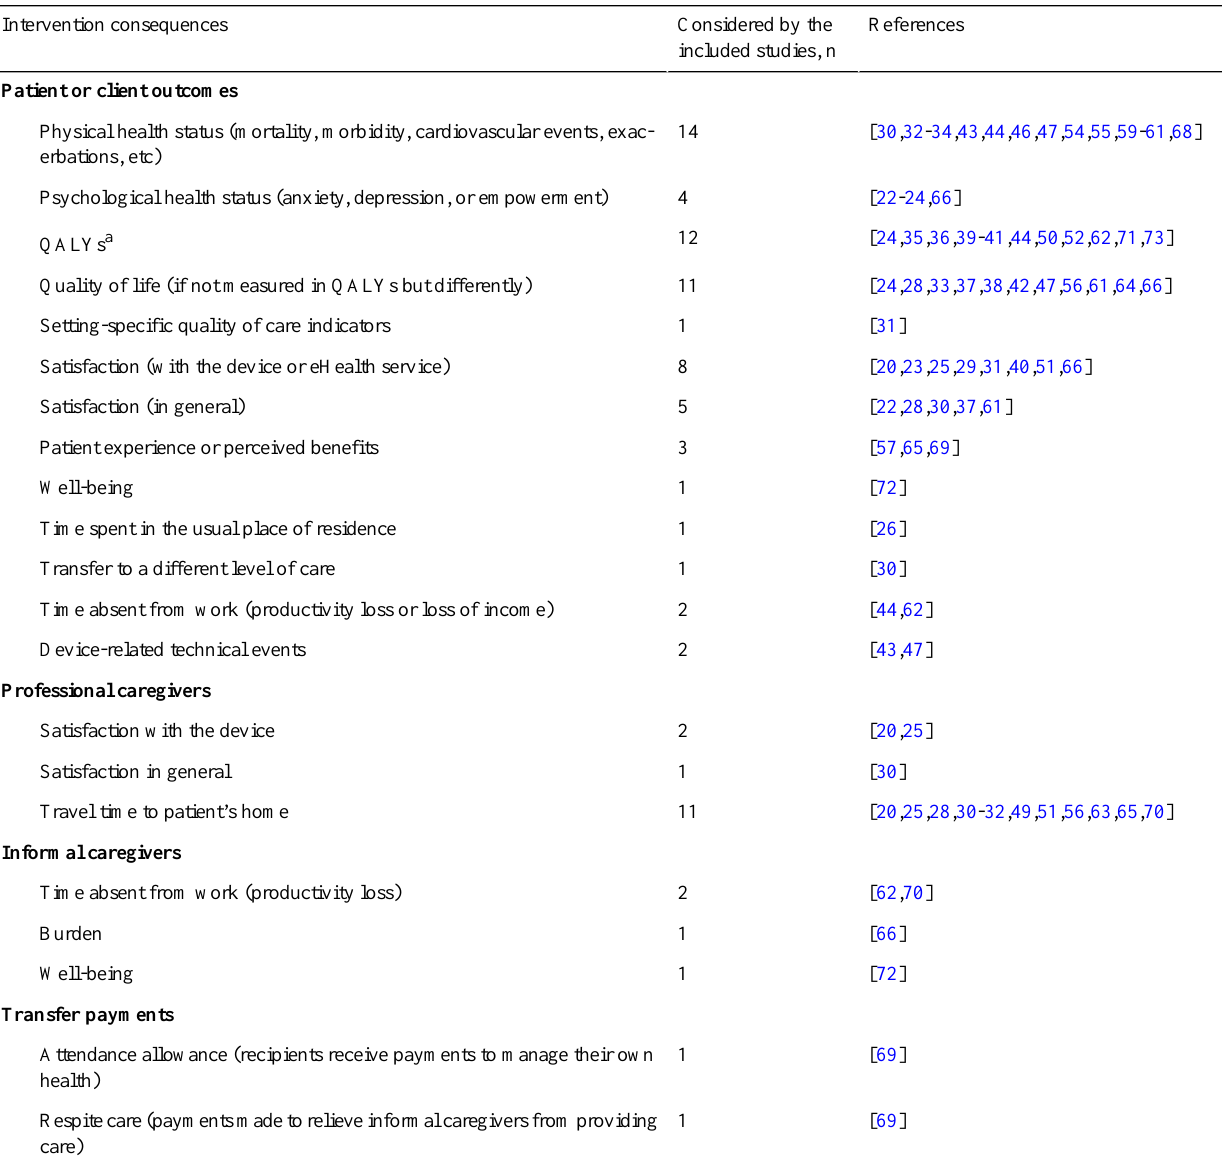
Table 3. Intervention consequences—stakeholder outcomes. nIntervention